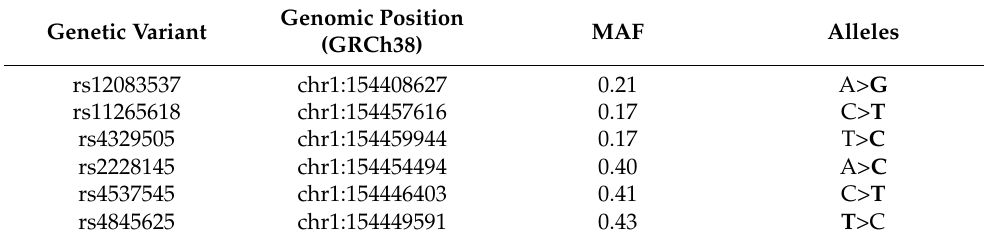
Table 1. Selected functional polymorphisms in the IL6R